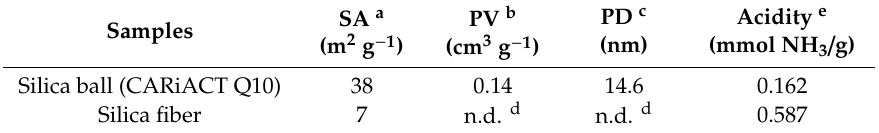
Table 1. Textural properties and acidity of the silica ball and silica fiber.